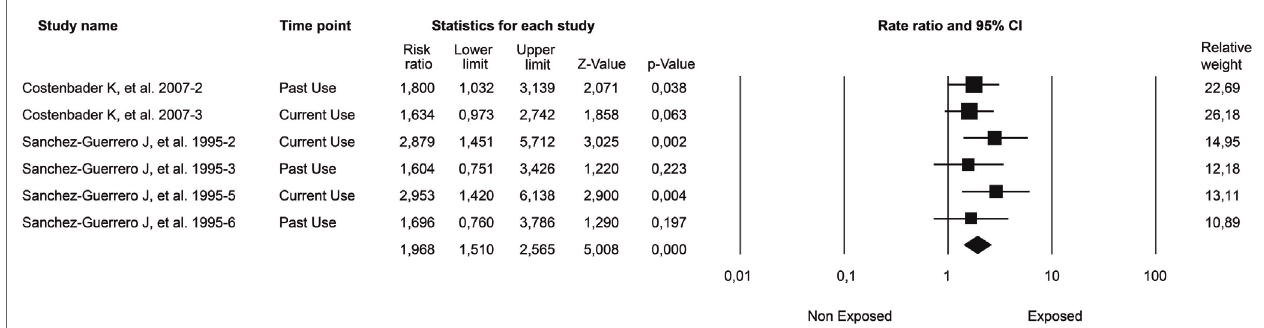
FiGURe 9 | Association between hormonal replacement therapy (HRT) exposure and risk of developing SLe . Forest plot of studies meta-analyzed. Final common effect size based on a random model. CI: confidence interval; SLE: systemic lupus erythematosus; HRT: hormonal replacement therapy. Adapted with authors’ permission from Ref.